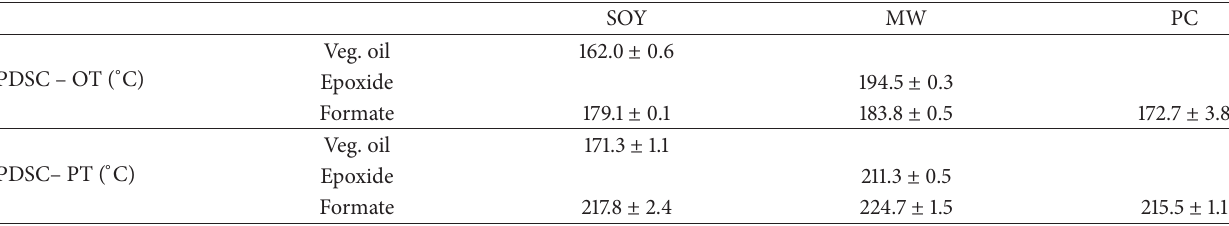
Table 3: Oxidation stability of vegetable oils, epoxides, and formate esters ( a ) . SOY